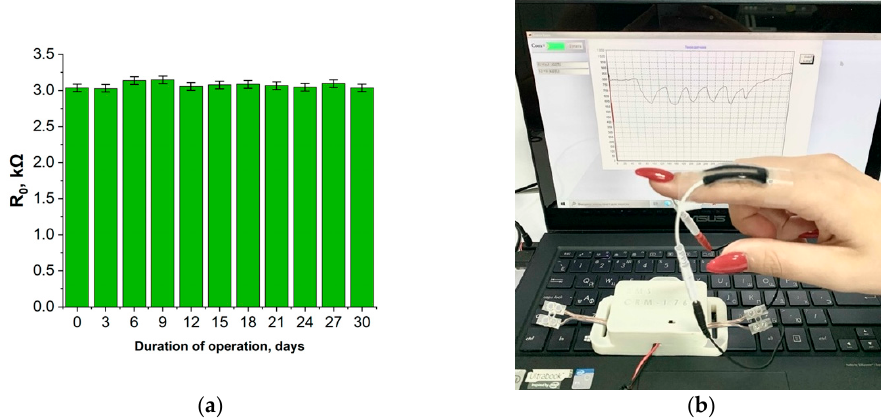
Figure 11. ( a ) Resistance value of the strain sensor after cyclic tests monitored for a month; ( b ) pro- cedure for real-time measurement of finger joint